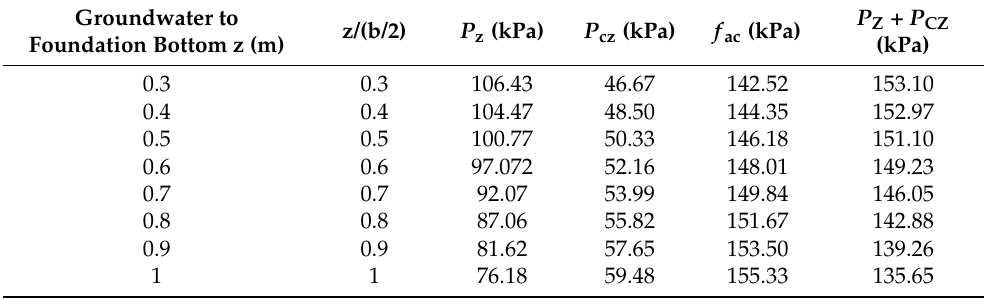
Table 12. Calculation results of foundation bearing capacity (b = 2.0 m, d = 2.75 m). Groundwater to Foundation Bottom z